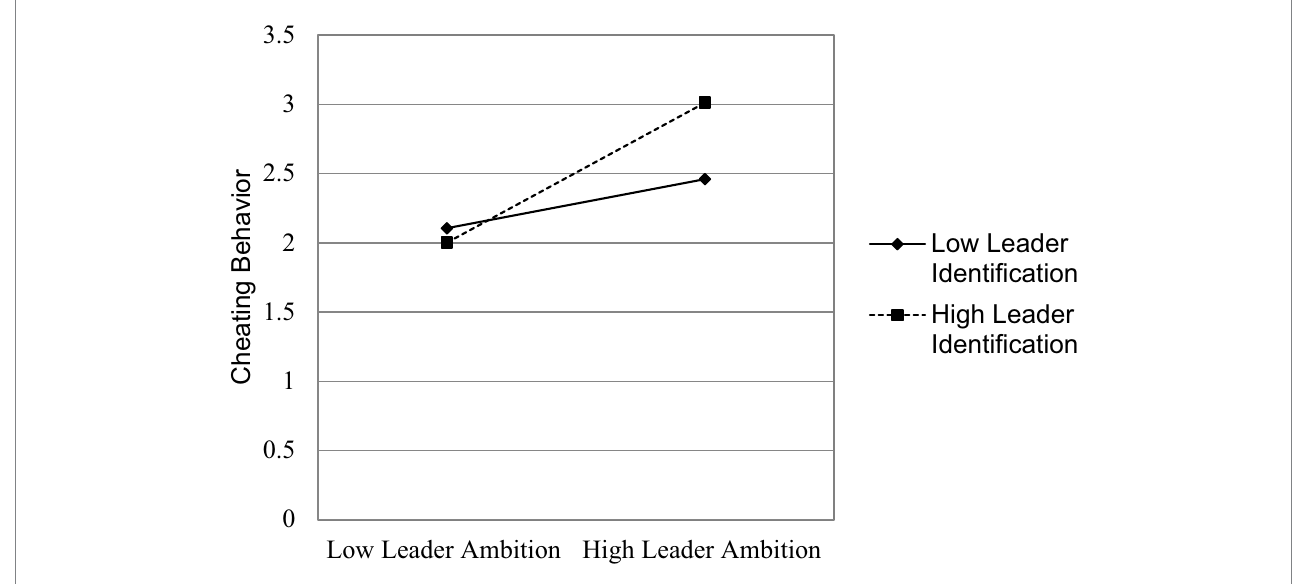
FIGURE 3 Study 2: interaction of leader ambition and leader identification.